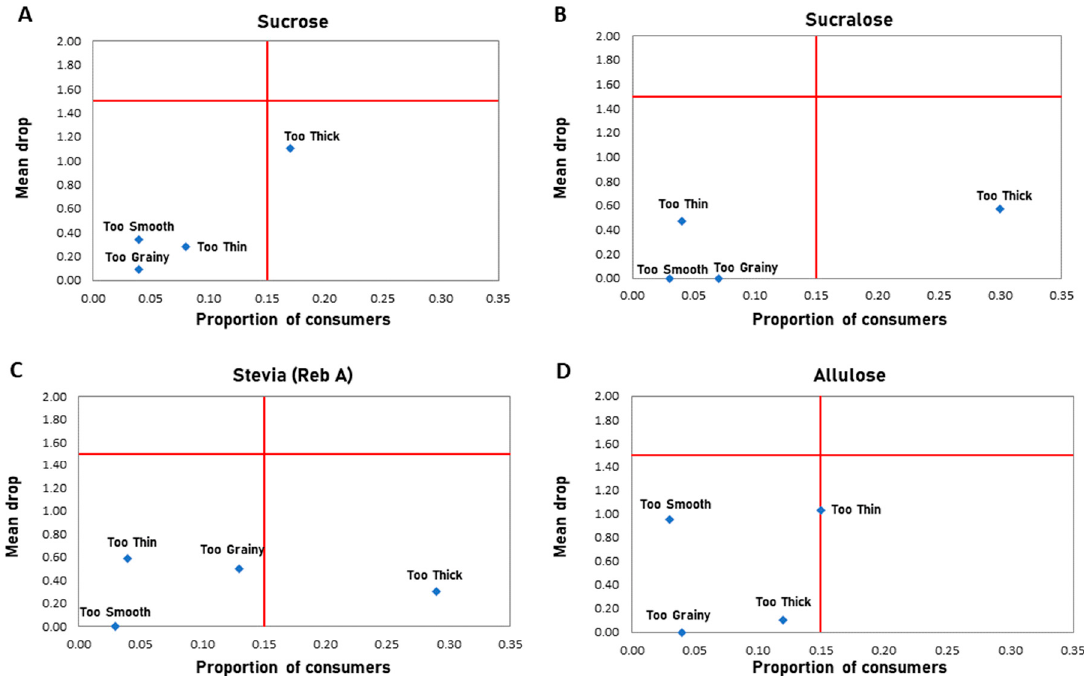
Figure 6. Penalty analysis of sweetened yogurt samples. Penalty analysis showing the attributes negatively impacting the overall liking (mean drop), and proportion of consumers agreeing for yogurt products sweetened with ( A ) Sucrose, ( B ) Sucralose, ( C ) Stevia, ( D ) Allulose.